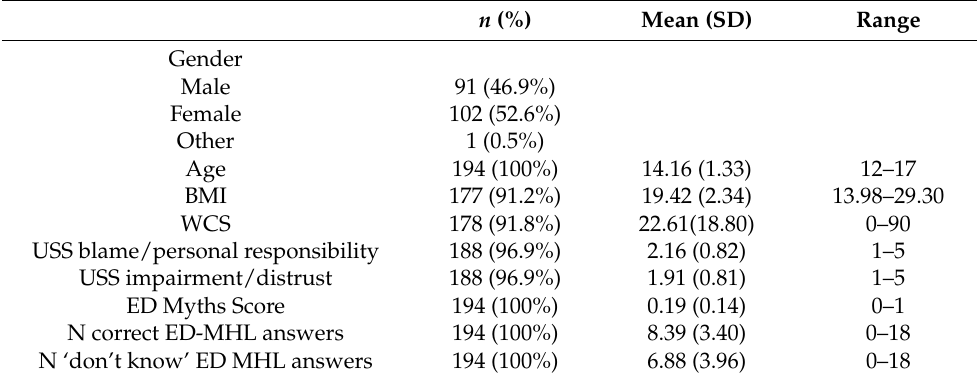
Table 1. Demographics, Body Mass Index (BMI), Weight Concerns Scale (WCS), Universal Stigma Scales (USS), Eating Disorder (ED), Myths score, and Number of Correct ED Mental Health Literacy (ED-MHL) statements of N = 194 German Adolescents. n (%) Mean (SD)